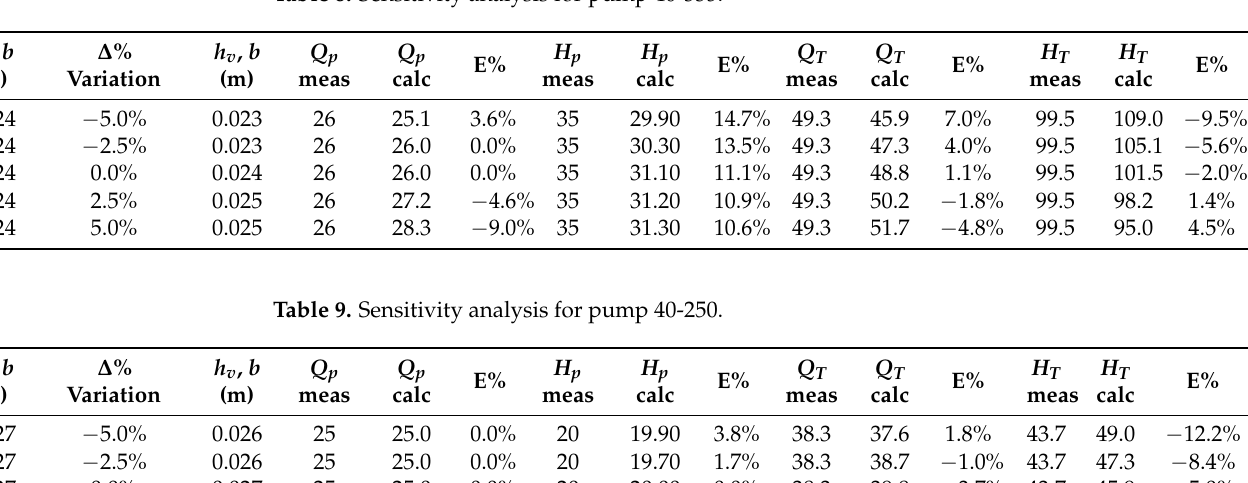
Table 8. Sensitivity analysis for pump 40-335.